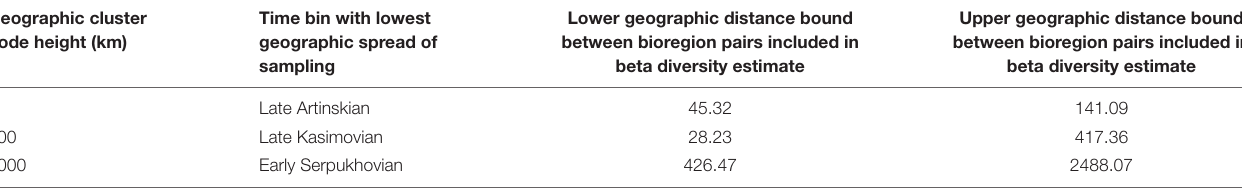
Upper geographic distance bound between bioregion pairs included in beta diversity